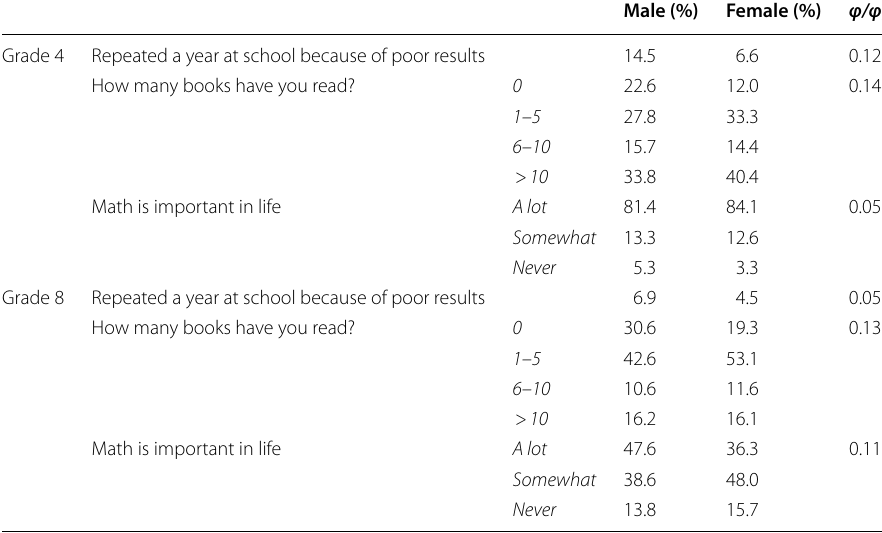
All differences are statistically significant at the .001 level